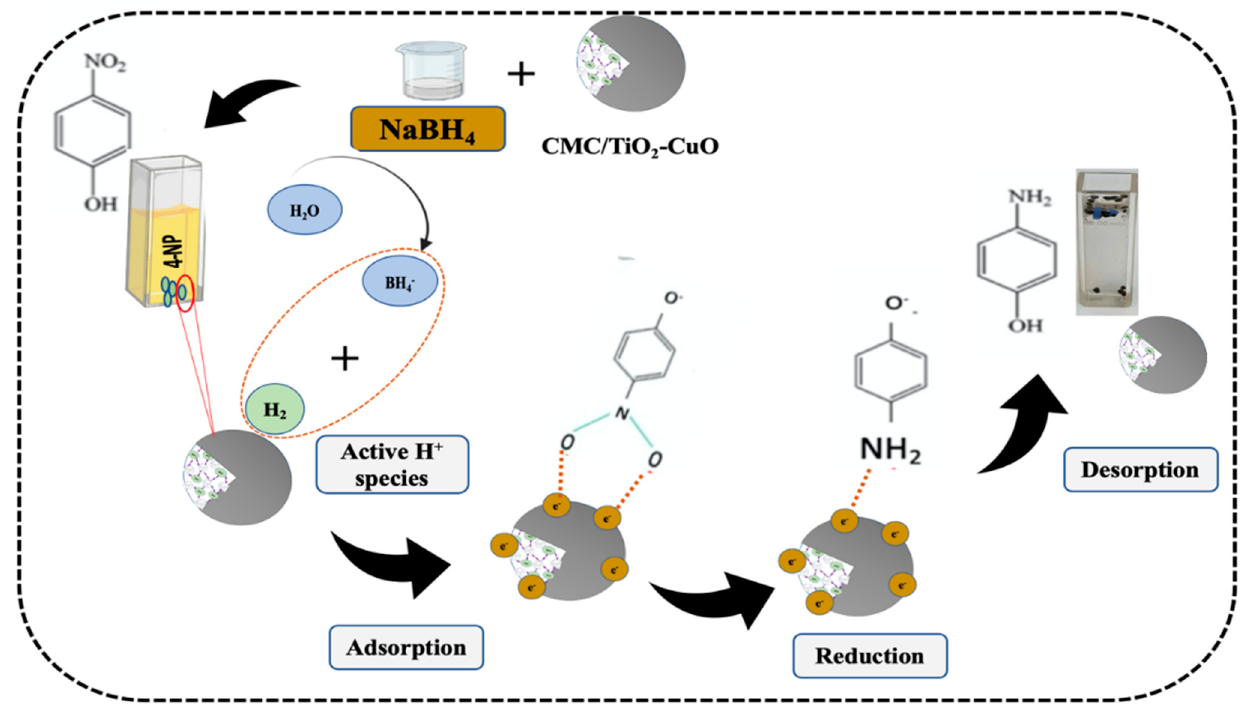
Figure 6. Schematic representation for the catalytic reduction of 4-NP.